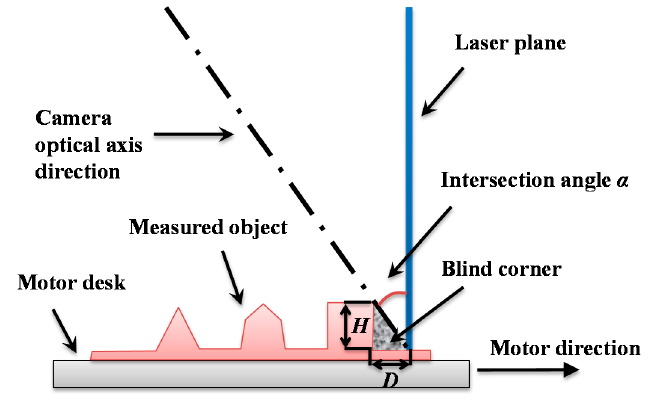
Figure 2. Formation mechanism of the blind corner. Figure 2 indicates that the shaded region along the movement direction is not able to be measured. The region area is characterized by the width D directly when H is